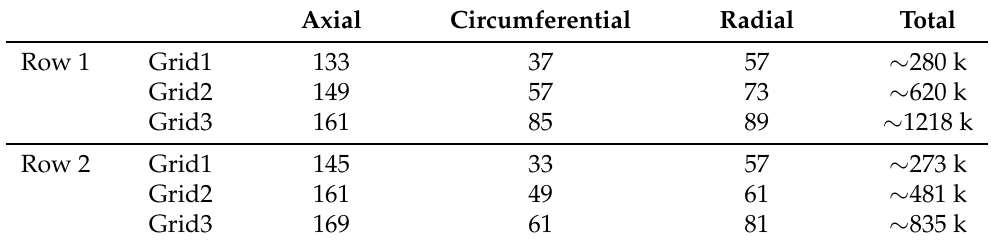
Table 1. Grid nodes in the three coordinate directions for NASA stage 35.